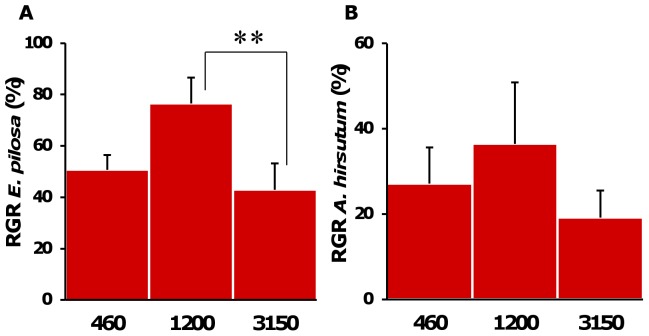
Growth of the bryozoan.Relative growth rate (RGR) of (A) E. pilosa, (B) A. hirsutum colonies during the 30 days of incubations at 460 µatm, 1200 µatm and 3150 µatm pCO2. Data are the mean ± SE of the growth rates in % in n = 10 flasks. One-way ANOVAs, statistical significance: **: p≤0.01.